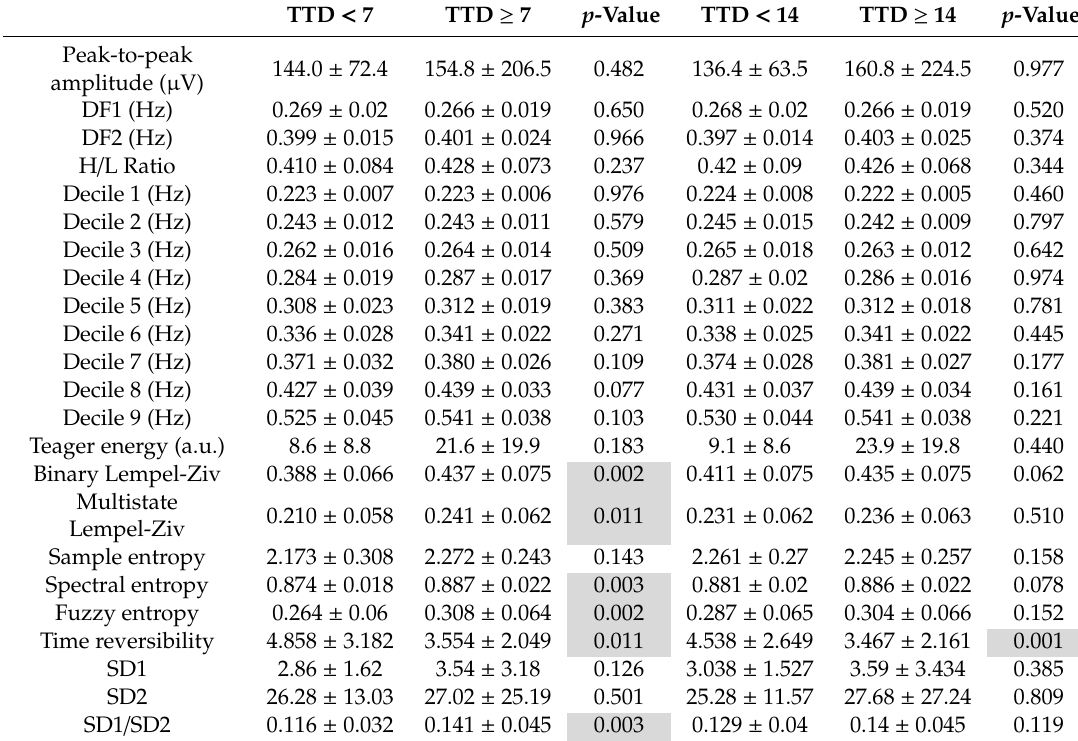
Table 3. Mean and SD of EHG characteristics of 7- and 14-day women. p -value < 0.05 (grey shading) indicates significant di ff erences between both